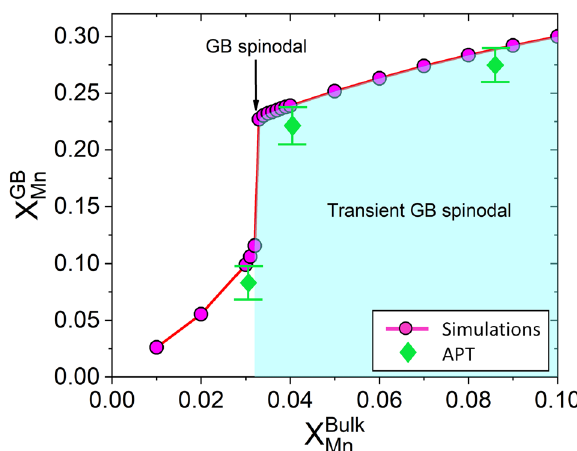
Fig. 7 GB segregation isotherms for the Fe – Mn system at 450 °C. An atomic GB density ρ GB = 0.75 and a gradient energy coef fi cient = 5 × 10 − 18 J m 2 mol − 1 were used for these calculations. The κ X abrupt jump in the GB concentration (GB spinodal) is found for an alloy with ~3.33 at.% Mn. Above this composition a transient GB spinodal was revealed through 3D simulations. The green points indicate the highest GB concentration obtained from the APT measurements for alloys with 3.0, 4.0, and 8.6 at.%